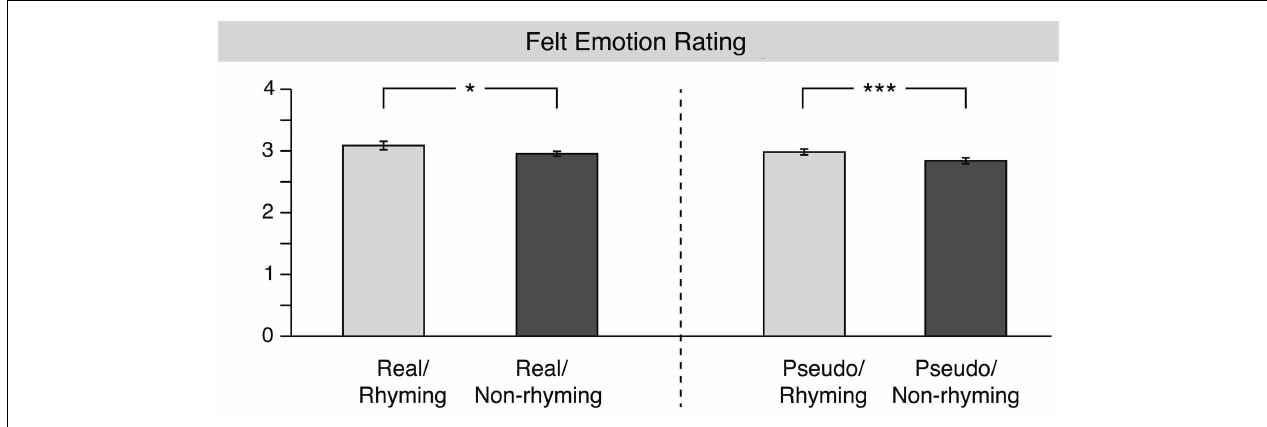
FIGURE 4 | Results for the “felt emotion” rating. The left part shows the main effect of rhyme for the real word stanzas, whereas the right part depicts the main effect of meter for the pseudo-word stanzas.